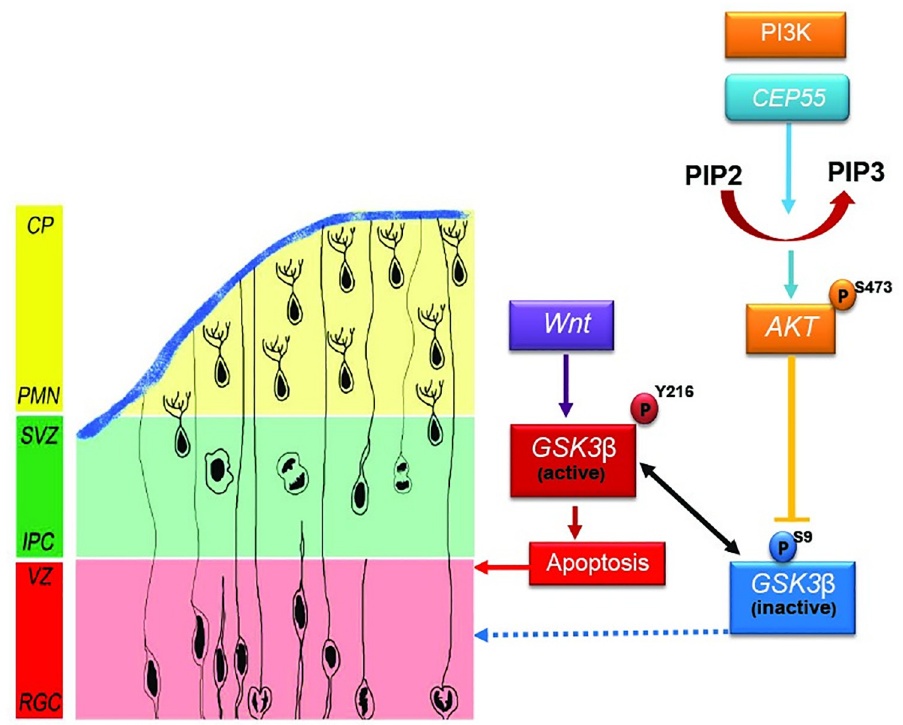
Fig 7. Graphical abstract. Proposed model of Cep55-dependent regulation of RGC proliferation or apoptosis through PI3K/Akt and the downstream targets Gsk3 β , β -Catenin and Myc. CEP55 is known to bind the catalytic subunit of PI3K (p110) and promotes downstream phosphorylation of AKT (S473). The active AKT inactivates GSK3 β by phosphorylating it on S9. However, in Cep55 KO cells, downregulation of Akt phosphorylation leads to upregulation active Gsk3 β (Y216) and consequent cell death which can be rescued by Gsk3 β inhibition. Ciliogenesis is regulated in an Akt-dependent manner and independent of Gsk3 β .